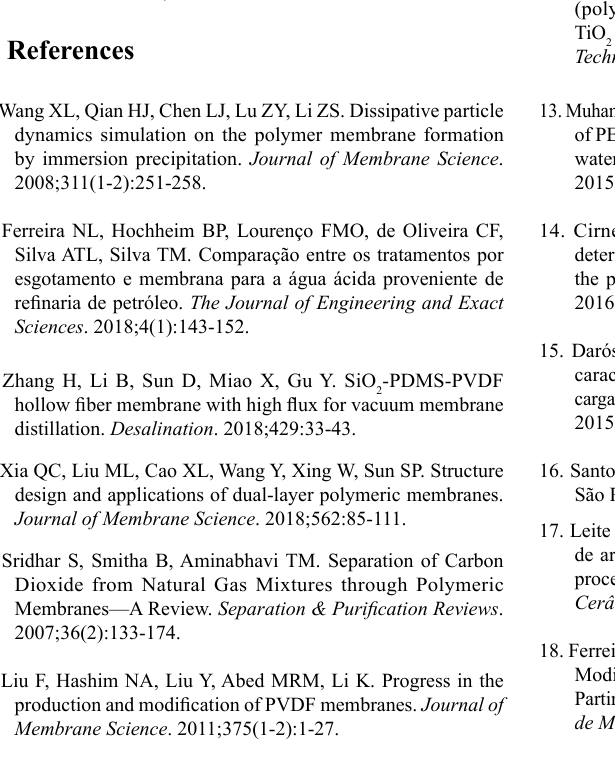
Table 4. Values of C